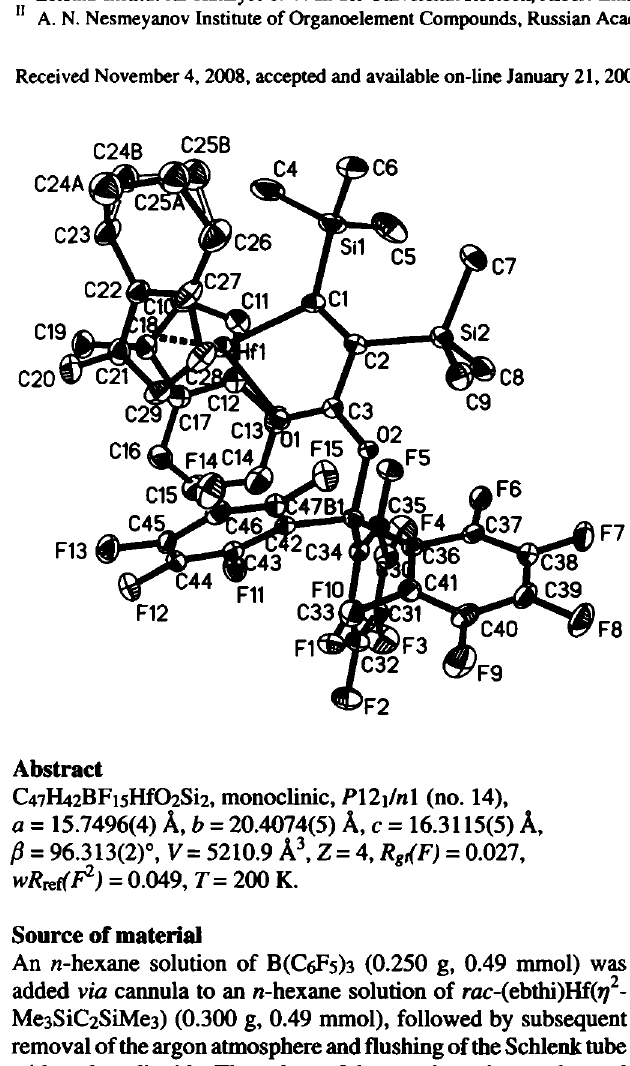
Table 1. Data collection and handling.